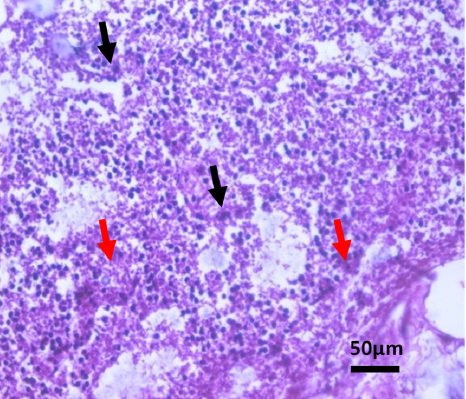
Figure 14. Sections treated with P. roxburghii extract showed a scattered sheet of dysplastic epithelial cells with rounded nuclei with an increased nucleocytoplasmic ratio ( black arrow ), with many apoptotic cells and necrosis ( red arrows ) (HE, ×400).